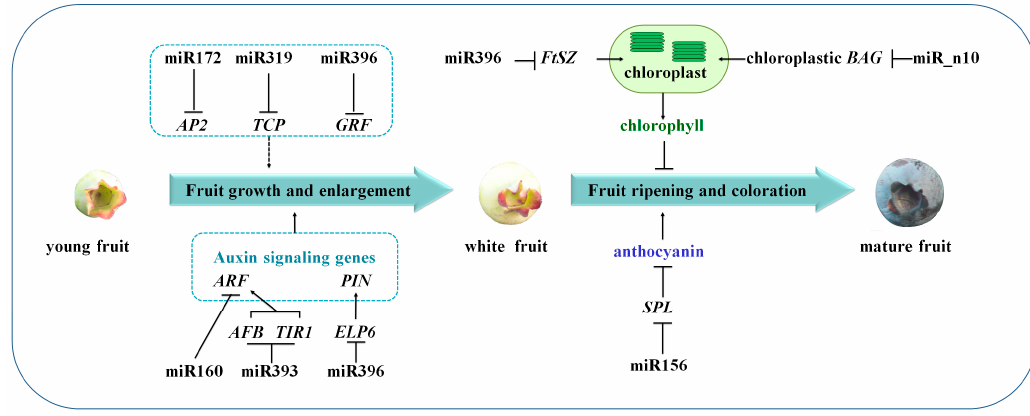
Figure 8. A schematic model showing the proposed roles of miRNAs involved in blueberry fruit development and ripening. T bar and arrow refer to negative and positive effect on downstream effector or biological process, respectively.